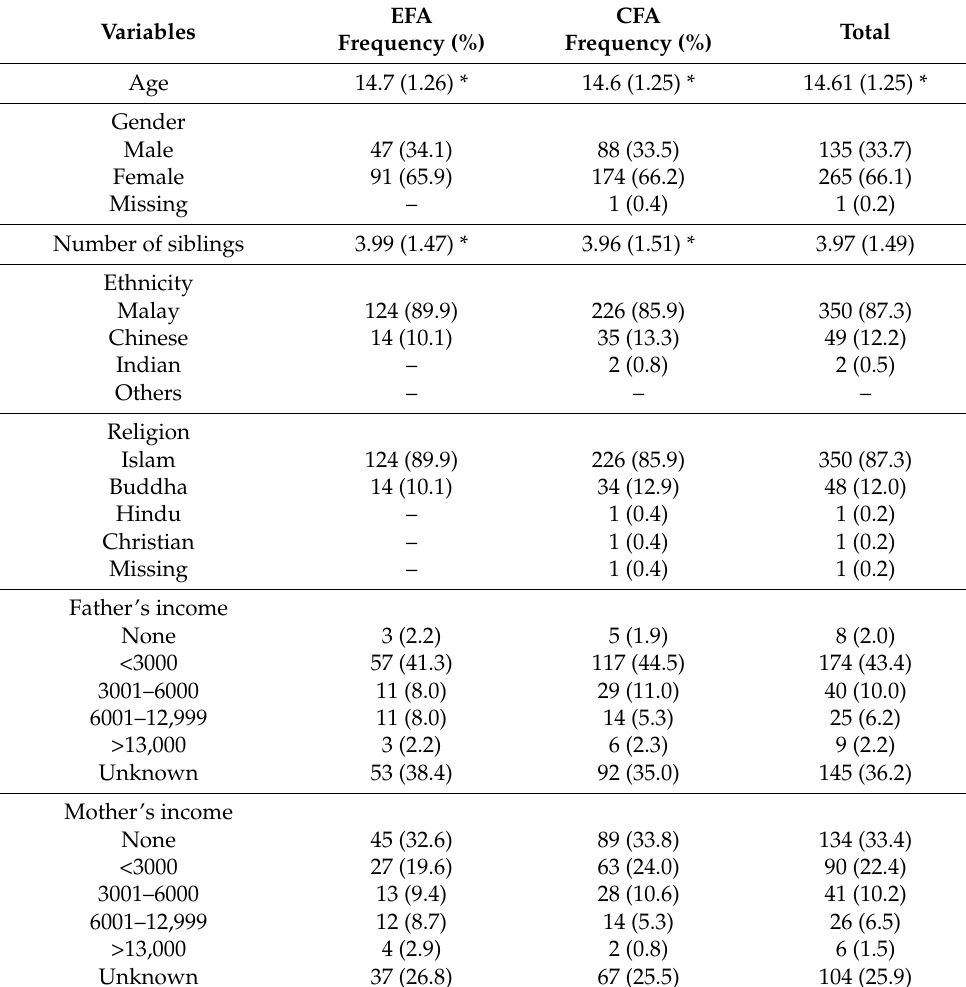
Table 1. Sociodemographic data of participants for EFA ( n = 138) and CFA ( n = 263). Variables